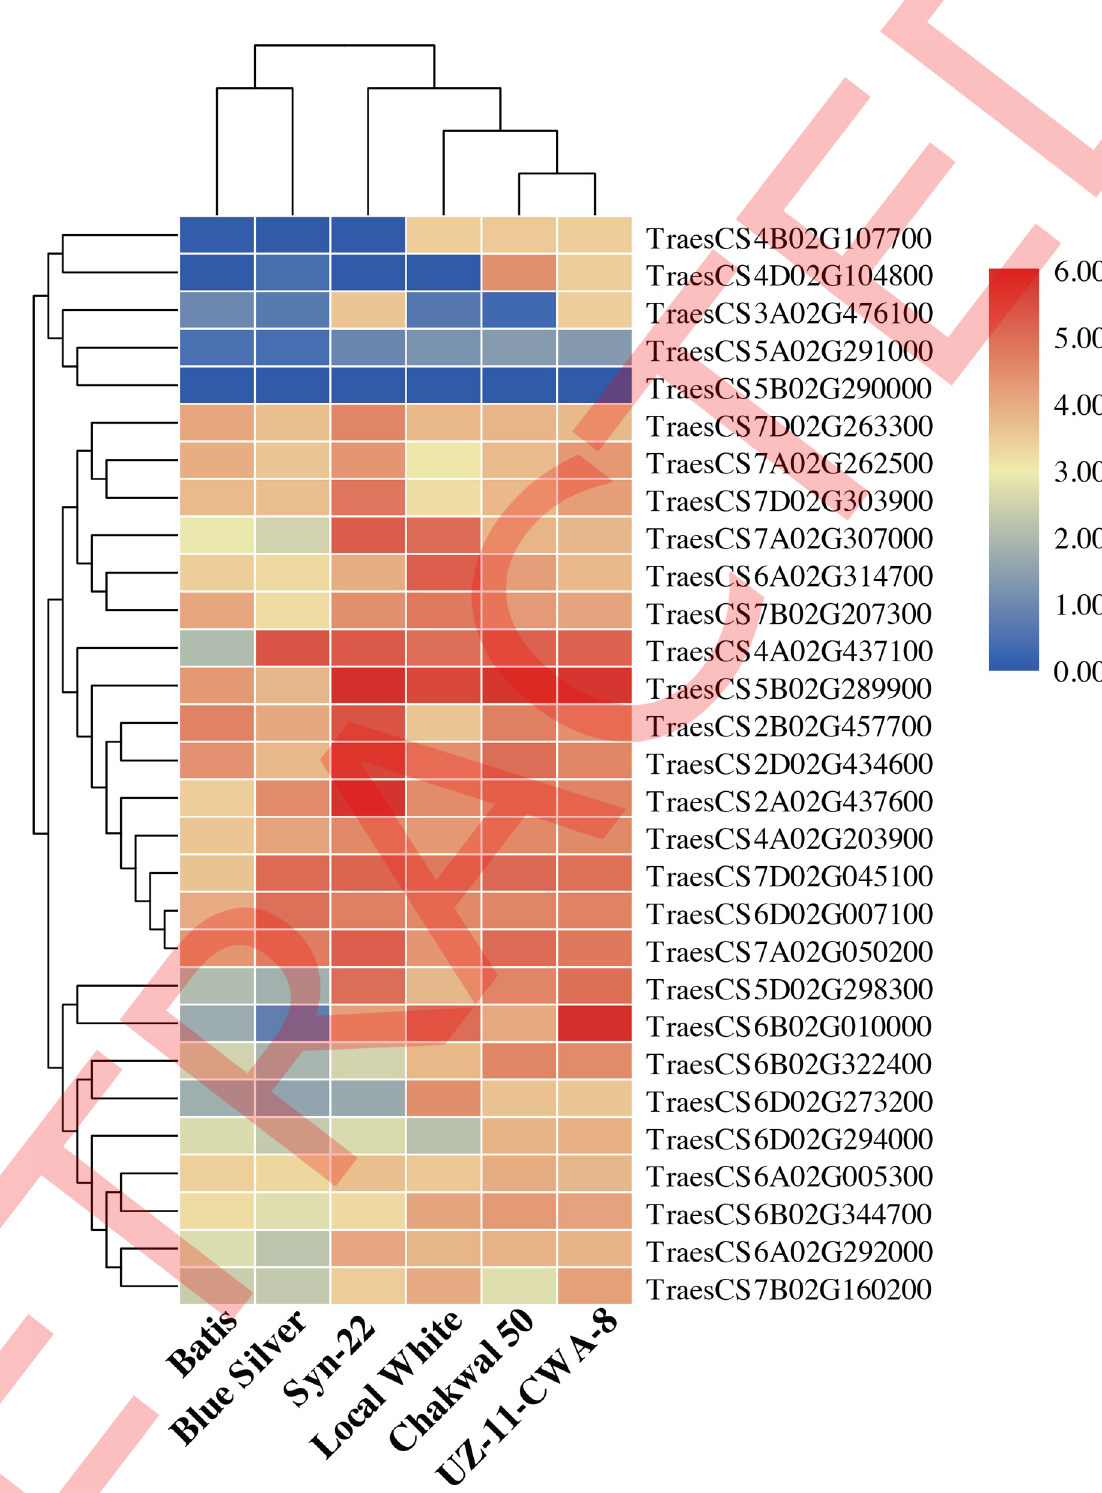
Fig 6. Visualization of differentially expressed genes of MORF/RIP (rows) by RNA seq in six genotypes of wheat. Blue indicates low, Brown indicates medium red indicates high expression in heatmap.